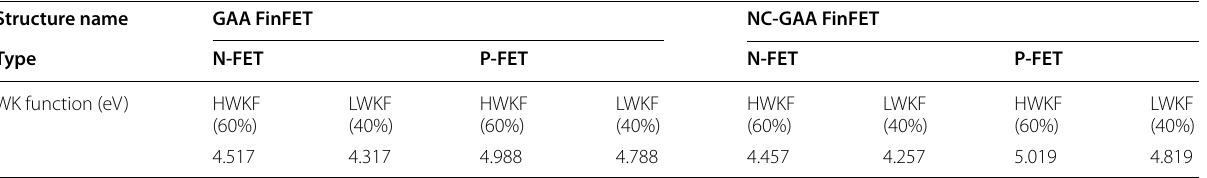
Both N-/P-type GAA FinFETs are set as the different WK and compared with NC devices in the statistical device simulation